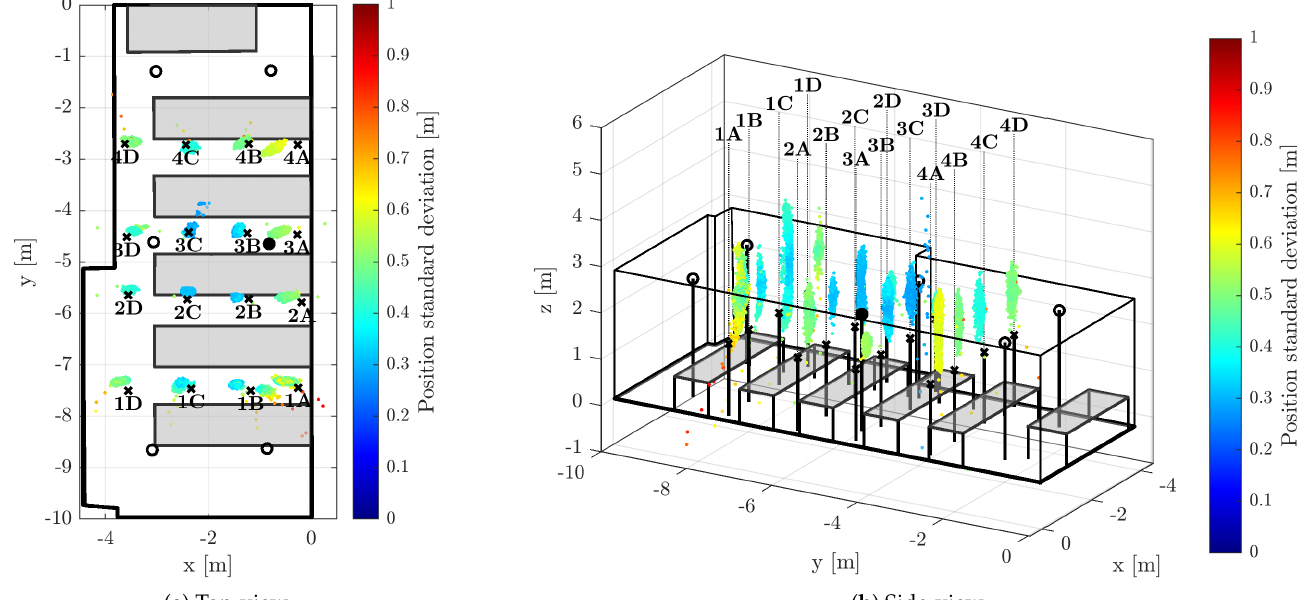
Figure 8. 3D Position estimates obtained using EKF with clock drift